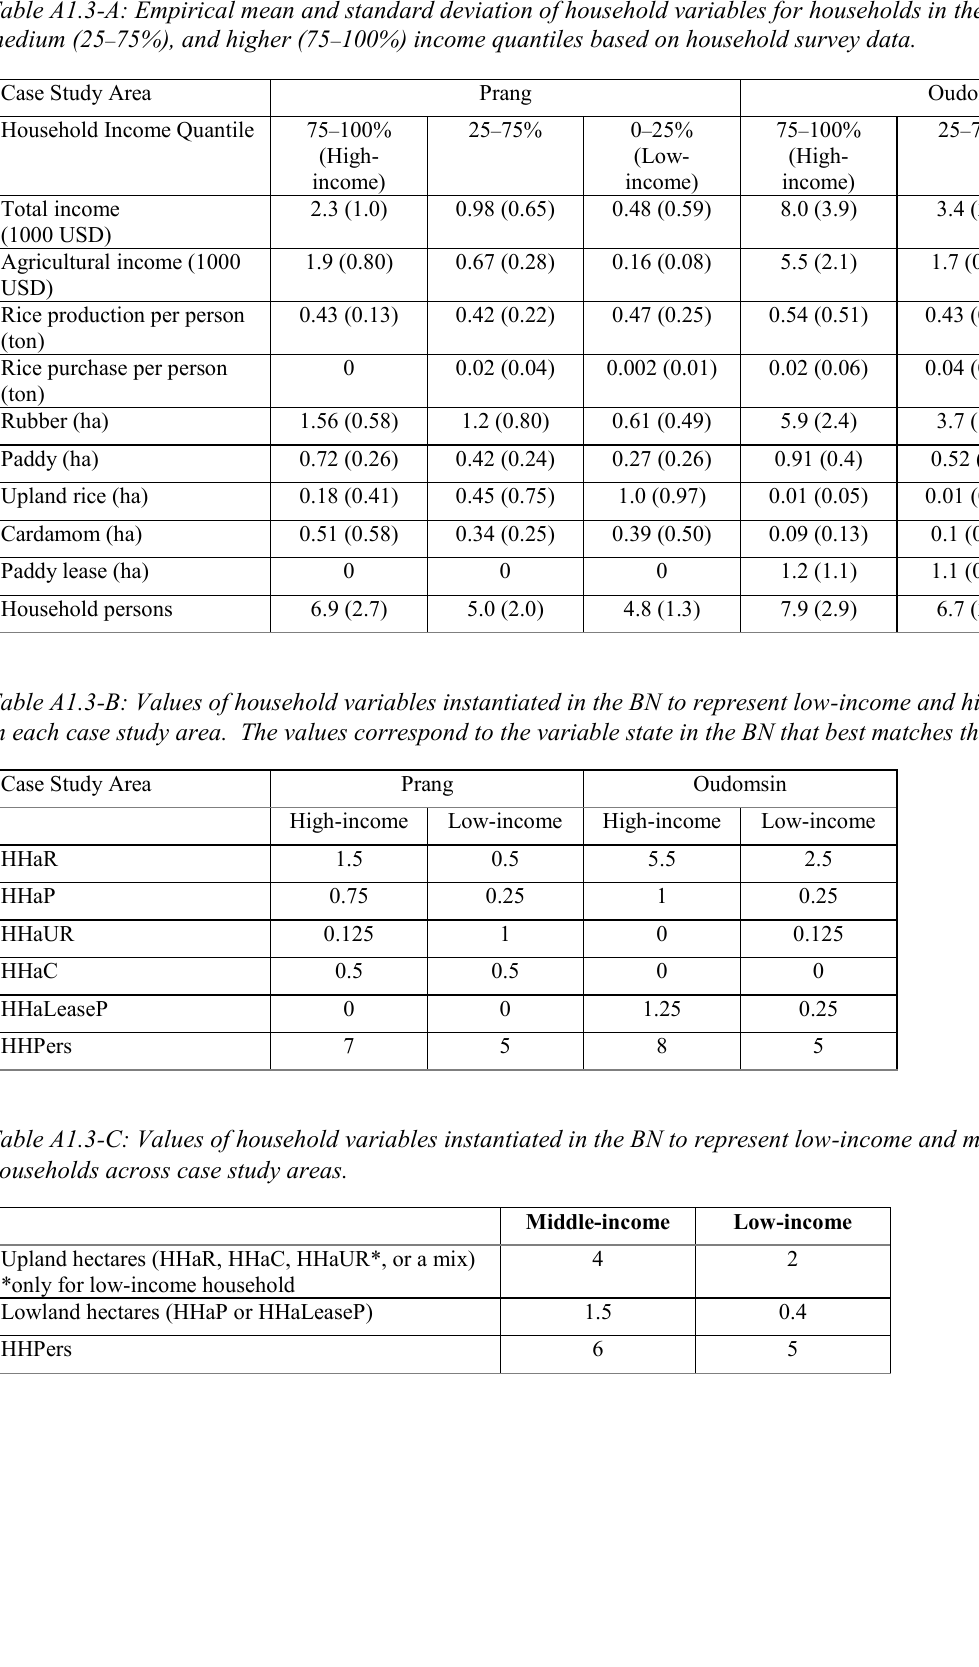
Table A1.3-A: Empirical mean and standard deviation of household variables for households in the lower (0 – 25%),